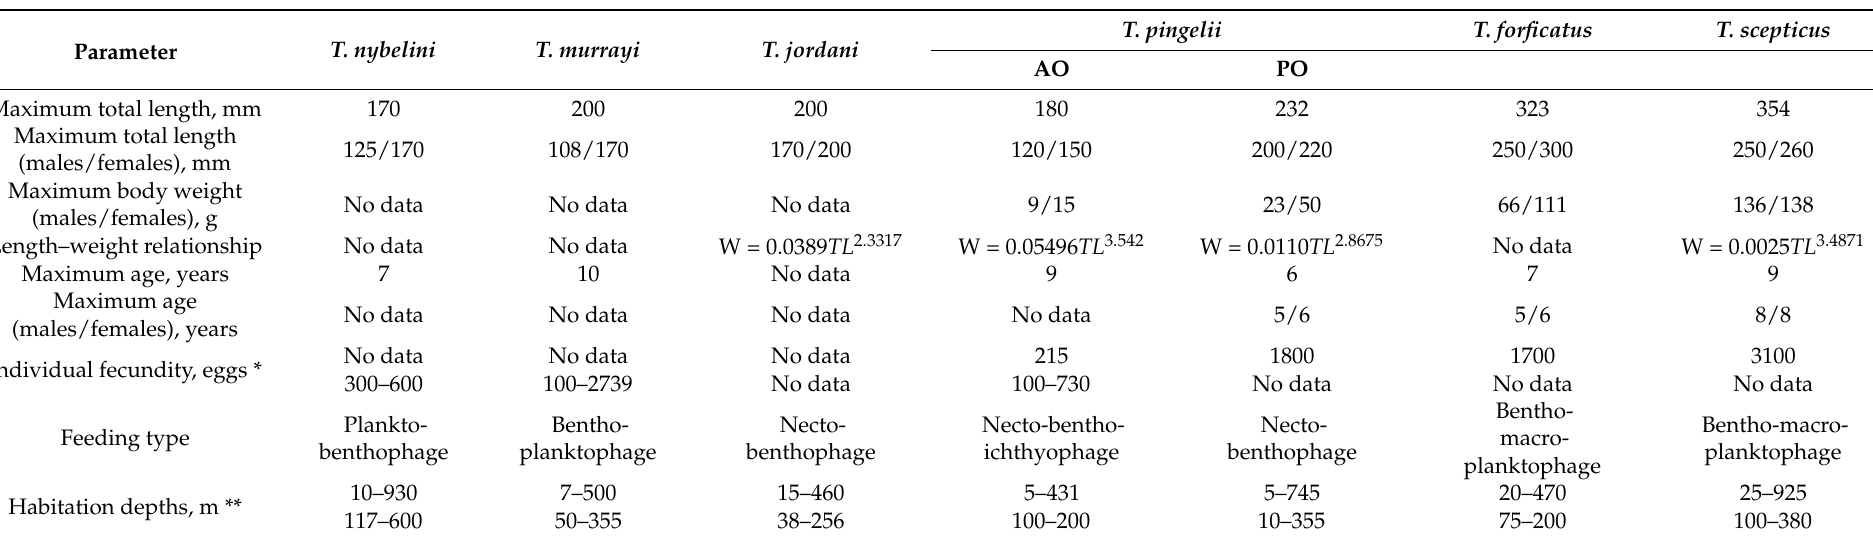
Table 5. Some biological parameters and habitat depths of the most numerous or common sculpin species of genus Triglops (based on [4,12,14,17,22,24,25,28,30,47–50,54–59]).